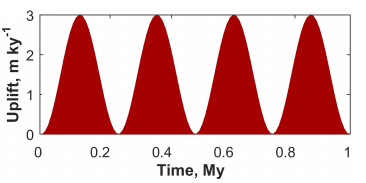
Figure 3. Uplift imposed on the steady-state landscape shown in Fig. 2 to investigate the impact of different numerical schemes.